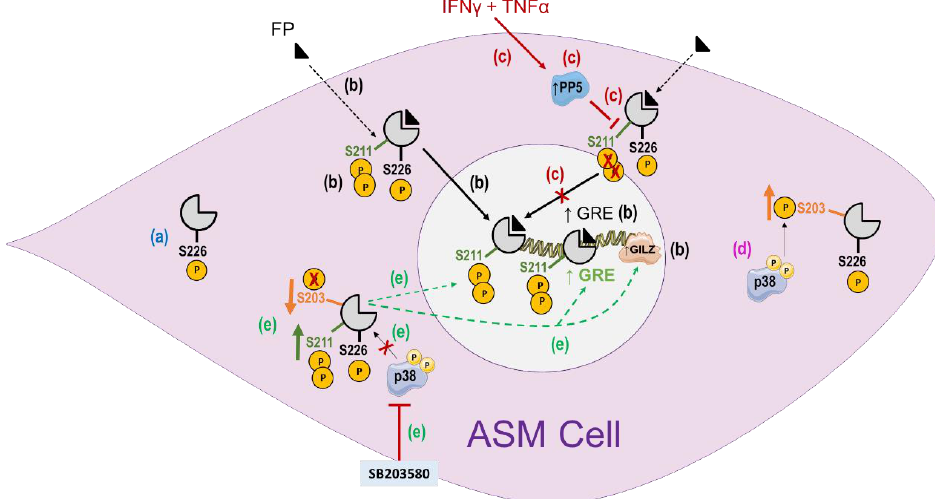
Figure 1 . The role of GR site-specific phosphorylation in regulating GC response in airway smooth muscle (ASM) cells. ( a ) GR is constitutively phosphorylated at Ser226. ( b ) Phosphorylation at Ser211 is critical for its transcriptional activity. Glucocorticoids (GCs) such as fluticasone propionate (FP) increase GR phosphorylation at Ser211, its subsequent nuclear translocation, and its DNA binding to glucocorticoid responsive elements (GRE) present in the promoters of GC-dependent genes such as GILZ to induce their transcription. ( c ) Treatment with IFN γ /TNF α dramatically suppresses GC-induced phosphorylation at Ser211 but not at Ser226. PP5 mediates the IFN γ /TNF α suppres- sive effect on GR phosphorylation at Ser211. ( d ) Under resting conditions, p38 MAPK-dependent phosphorylation of unliganded GR at Ser203 preserves the inactive state of GR. ( e ) Pharmacolog- ical inhibition of p38 MAPK, using SB203580, reduces unliganded GR phosphorylation at Ser203 but increases its phosphorylation at Ser211, leading to its nuclear translocation and transactivation activities of GR, as evidenced by an increase in GRE reporter activity and GILZ